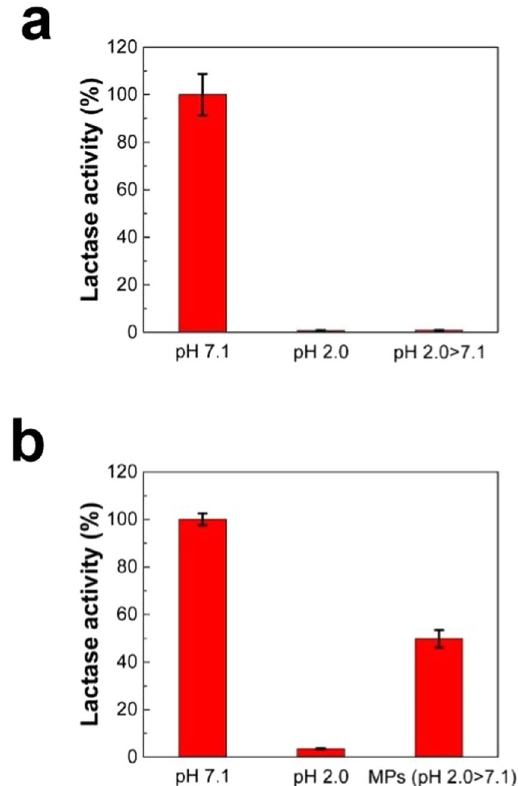
Figure 4. Protective effect of MP formulation on the functional activity of lactase. The relative activities of ( a ) a commercial lactase tablet and ( b ) MP-encapsulated lactase in simulated GI tract conditions ( n = 6, mean ± SD). Functional activity of lactase was calculated relative to that of control lactase at pH 7.1. In ( a ) and ( b ), pH 7.1 and 2.0 represent activity of lactase measured at pH 7.1 and 2.0, respectively, without using MPs. pH 2.0 > 7.1 represents activity of lactase in simulated GI tract